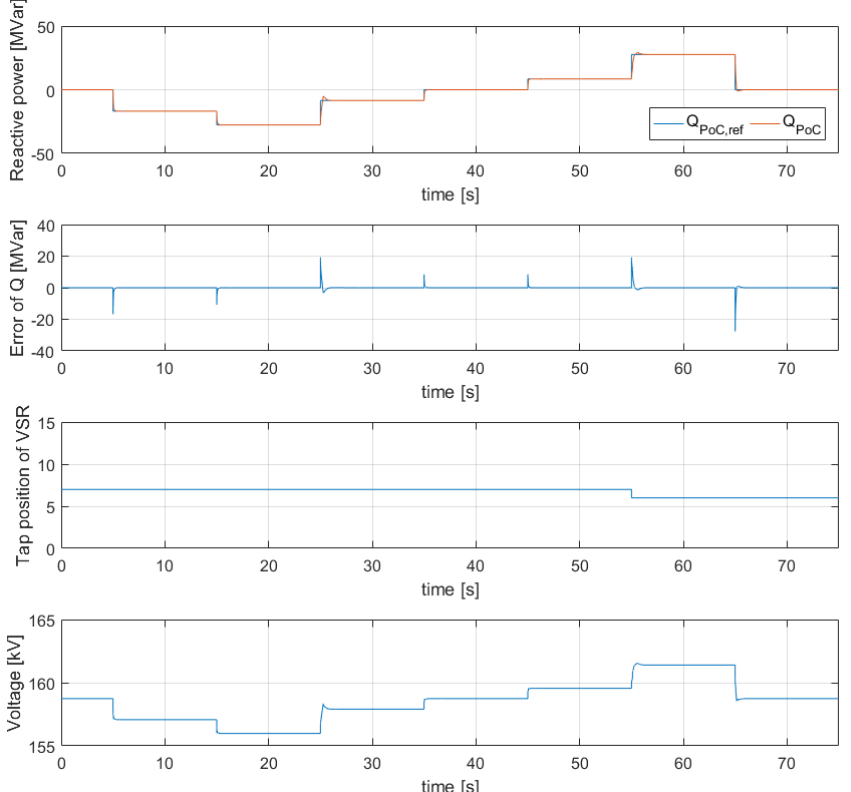
Figure 15. Set–point change control response of reactive power using proposed